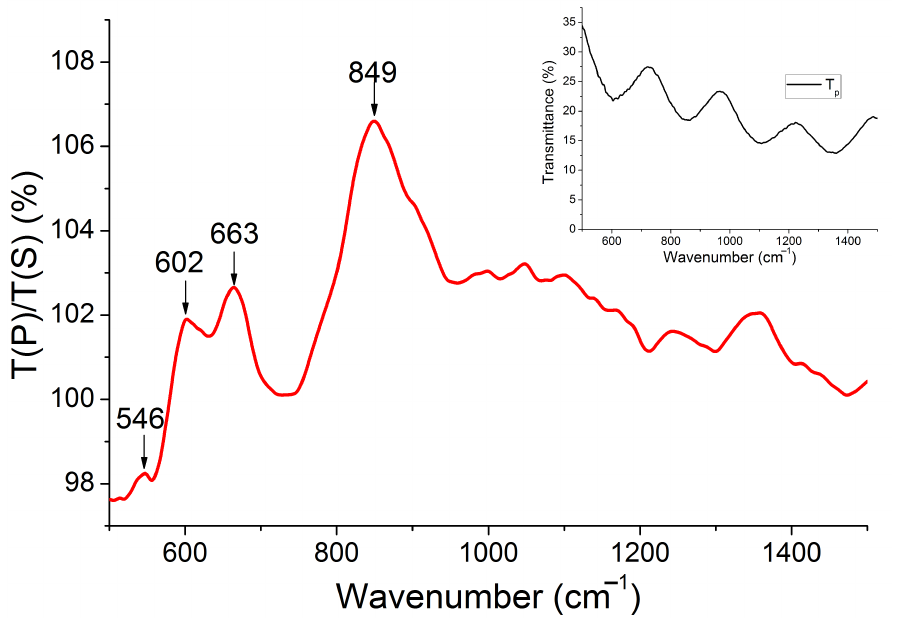
Figure 3. Ratio of the IR transmission spectra T ( φ = 90 ◦ ) / T ( φ = 0 ◦ ) . The spectrum at φ = 0 ◦ is shown in the